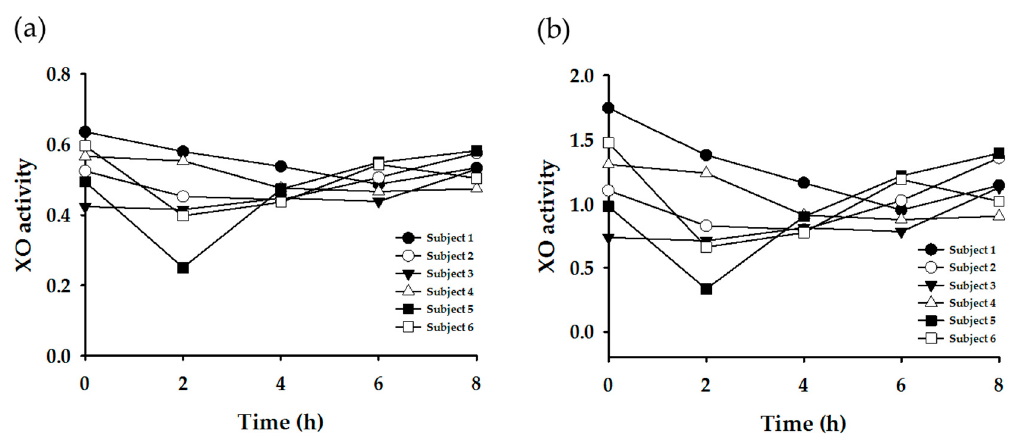
Figure 6. Plots of metabolite ratio for XO. The metabolic ratio equations used are as follows: ( a ) 1U/1X + 1U, ( b ) 1U/1X.